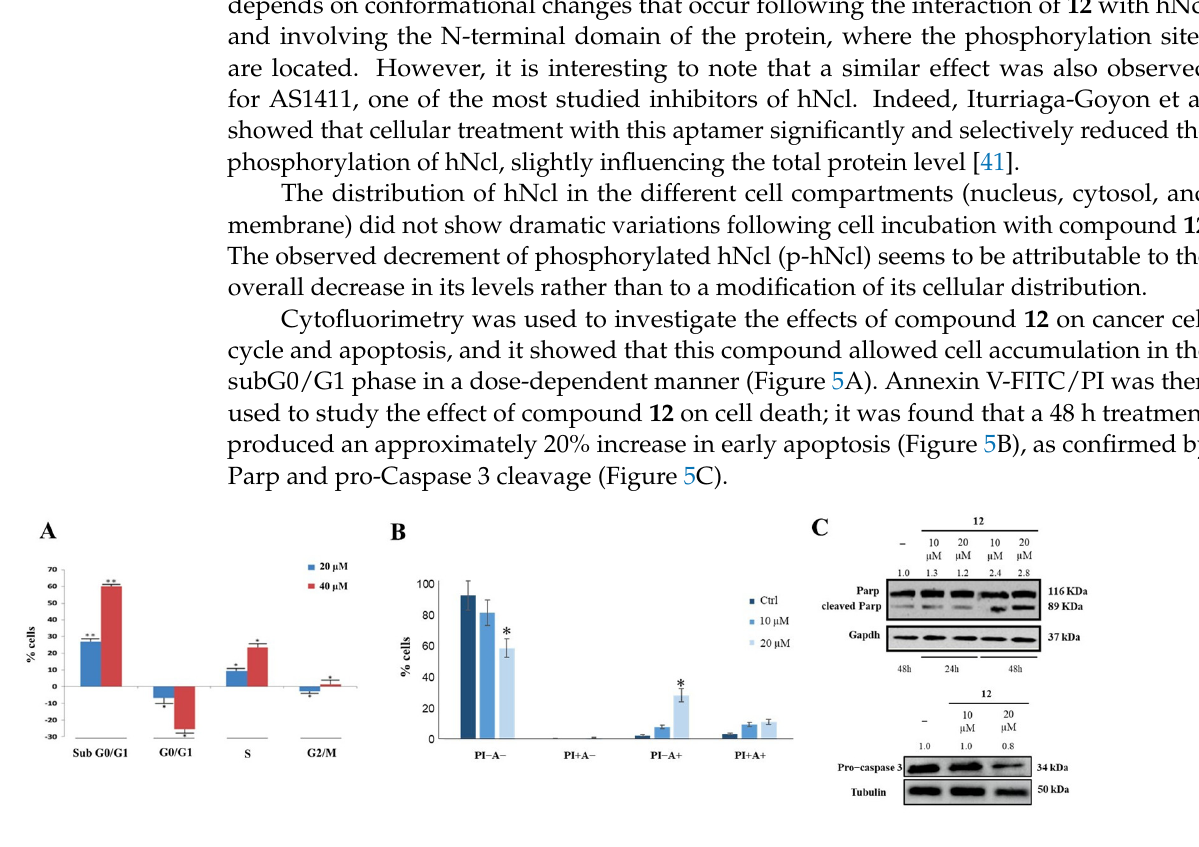
Figure 4. Nucleolin (Ncl) and phosphorylated Ncl (p − Ncl) levels. Western blot analysis of Ncl and p − Ncl in whole Hela cells ( A ) and in different cell compartments ( B ). The numbers shown above the blots indicate the results of densitometric analysis after normalization.